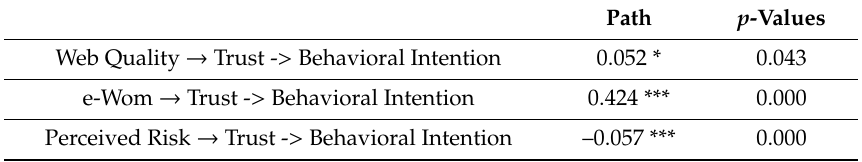
Table 7. Indirect e ff ects of Web Quality, e-Wom and Perceived Risk in Behavioral Intention. Table 7. Indirect effects of Web Quality, e-Wom and Perceived Risk in Behavioral Intention.